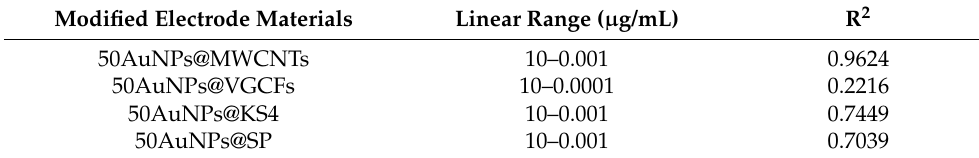
Table 2. Comparison of immunosensors using different kinds of CBNs for CA125 detection. Modified Electrode